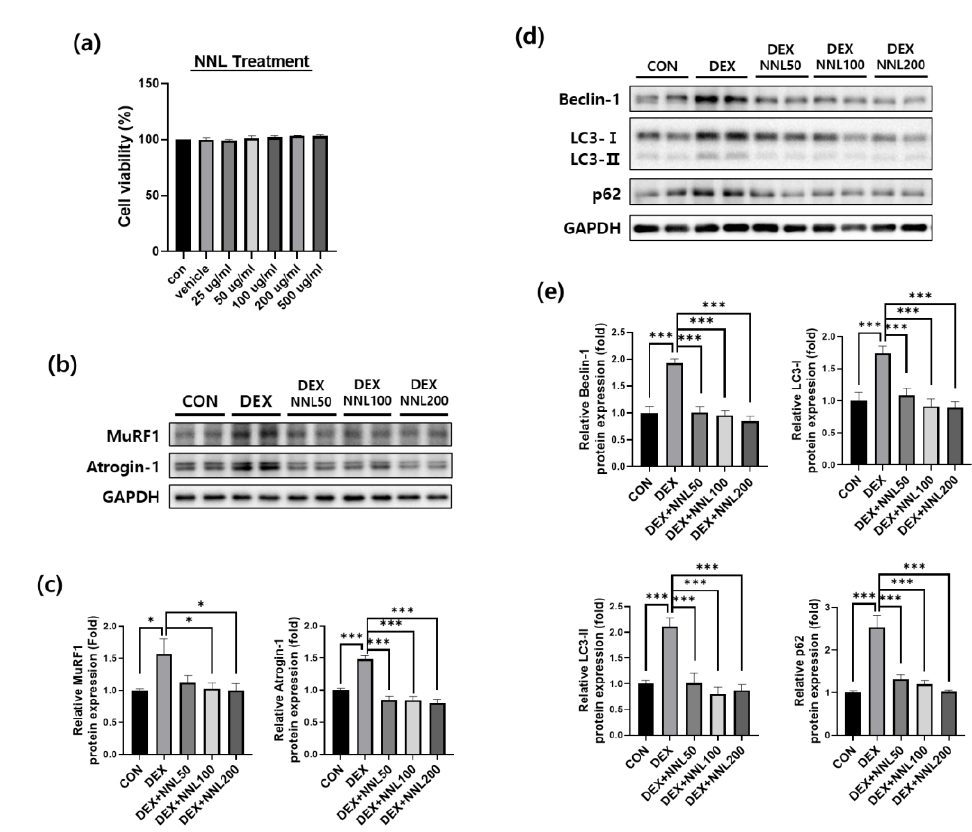
Figure 7. The NNL extract decreased the expression of the muscle degradation and autophagy factors in DEX-treated C2C12 myotubes. ( a ) C2C12 myoblasts were treated with NNL extract (25, 50, 100, 200, or 500 µ g/mL) for 24 h and cell viability was analyzed by CCK8 assay. ( b - e ) Differentiated C2C12 myotubes were treated with 50, 100, or 200 µ g/mL NNL extract for 24 h in the presence of DEX (100 µ M). The protein expression levels of MuRF1 and atrogin-1 ( b,c ), Beclin-1, LC3-I/II, and p62 ( d,e ) were analyzed by immunoblotting, quantified using ImageJ software, and normalized to GAPDH. The representative images ( b,d ) and quantitative analysis bar graphs ( c,e ) are shown. Data are shown as the mean ±S.E.M., n = 3/group; * p < 0.05, *** p < 0.001.